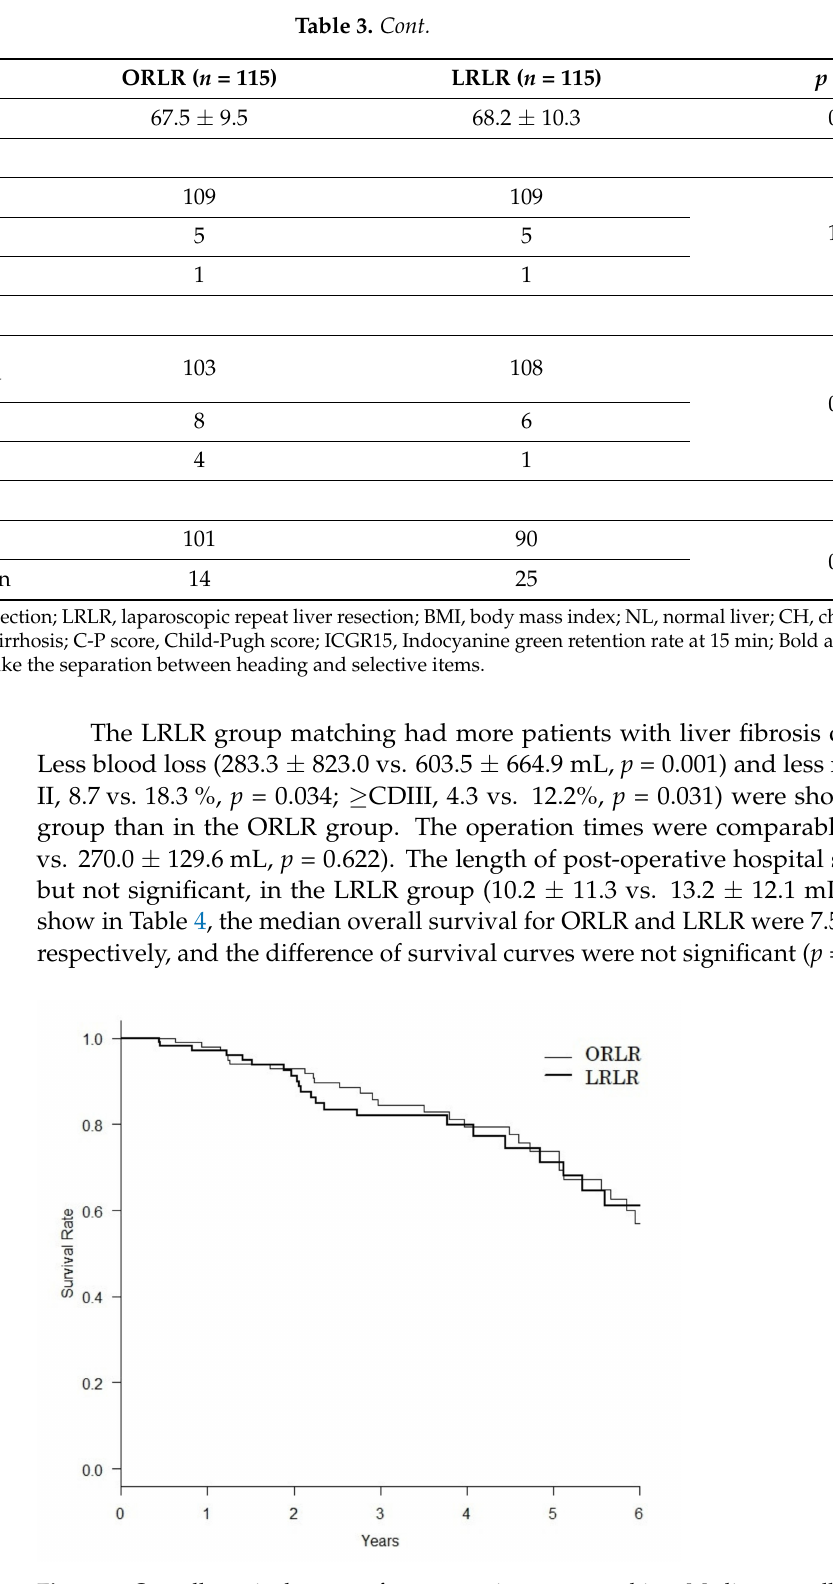
Figure 1. Overall survival curves after propensity score matching. Median overall survivals for open repeat liver resection (ORLR, thin line) and laparoscopic repeat liver resection (LRLR, thick line) were 7.51 and 7.14 years, respectively, and the difference of survival curves were not significant ( p =